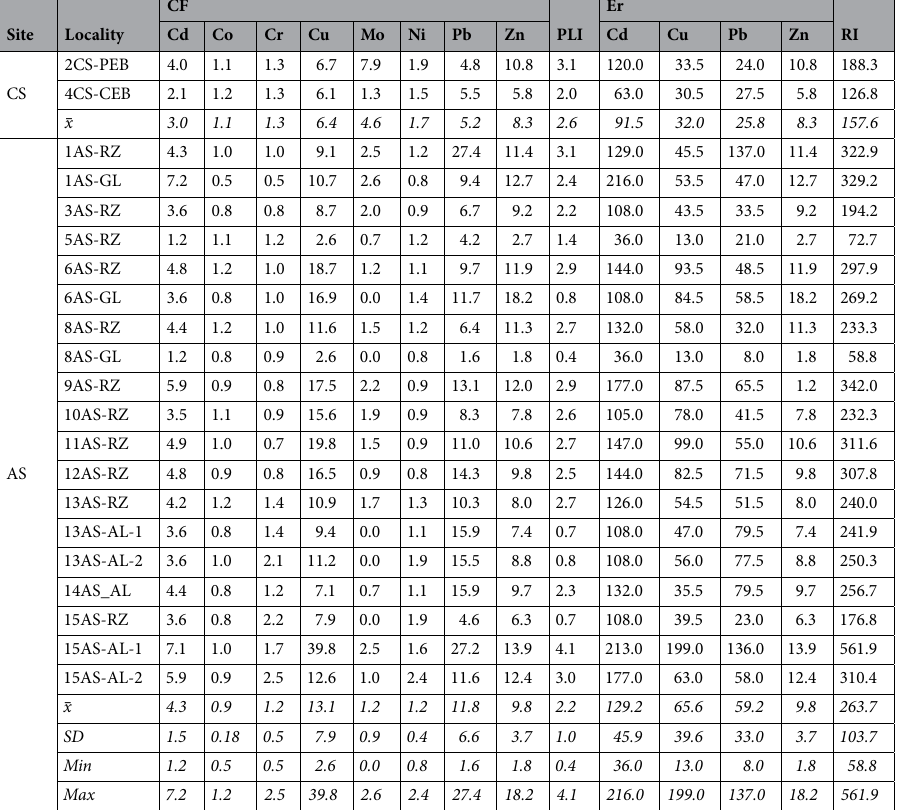
HMs were distributed in all four fractions (exchangeable, reducible, oxidisable, and residual) between the CS, AS, and RS localities (Fig. 2a–c). The content of HMs in the residual fraction was dominated at the RS localities (in 7 of 8 HMs). The study of the partitioning of HMs in the different fractions at the CS and AS localities revealed that Cd, Cu, Pb, and Zn were mainly associated with the first three fractions. The first exchangeable fraction was the highest in the case of Cd and Zn. Cu was mainly associated with the oxidisable fraction bound to organic matter and sulphides. The distribution of HMs in the different fractions, mainly in exchangeable ones, suggested that the mobility and bioavailability of the metals probably declined in the order of Cd, Zn, Cu, and Pb at AS localities, and Zn, Cd, Pb, and Cu at CS localities. The four most serious fractions of pollutants (Cd, Cu, Pb, Zn) in the Štiavnica River floodplain indicate their different distribution patterns. At AS localities, on average, the content of Cd represented 46.0% in residual, 28.4% in exchangeable, 20.9% in reducible, and 4.9% in oxidisable fraction. At CS localities, the highest percent- ages of Cd were associated with the reducible (32.2%), exchangeable (27.4%), residual (25.0%) and oxidisable (15.2%) fraction. At AS localities, on average, the Cu content accounted for 49.2% in oxidisable, 36.8% in residual, 8.3 in reduc- ible, and 5.7% in exchangeable fraction. At CS localities, the share of different fractions was similar, but the Cu share bond on organic matter and sulphides was higher (72.1%). At AS localities, on average, the content of Pb represented 46.7% in reducible, 37.0% in residual, 15.3 in oxi- disable, and 1.0% in exchangeable fraction. At CS localities, the share of different fractions was different, 51.5% in reducible, 32.9% in oxidisable, 4.2% in exchangeable, and 11.3% in residual fraction. At AS localities, on average, the content of Zn represented 42.3% in residual, 23.7% in reducible, 19.9% in exchangeable, and 14.1% in oxidisable fraction. At CS localities, the share of the different fractions was different, 34.4% in exchangeable, 26.2 in reducible, 25.1% in oxidisable, and 14.3% in residual fraction.